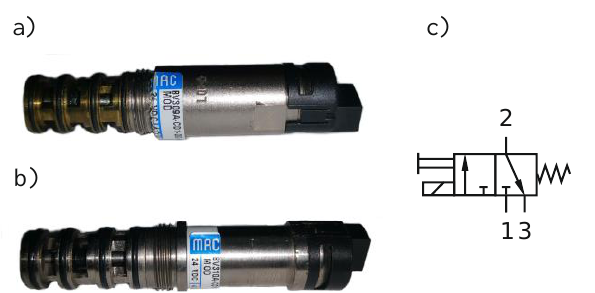
Fig. 3. General view of directional valve : a) BV309A-CD1-00- BGEA-CTA, b) BV310A-CD1-00-BHEA-CTA, c) pneumatic symbol.